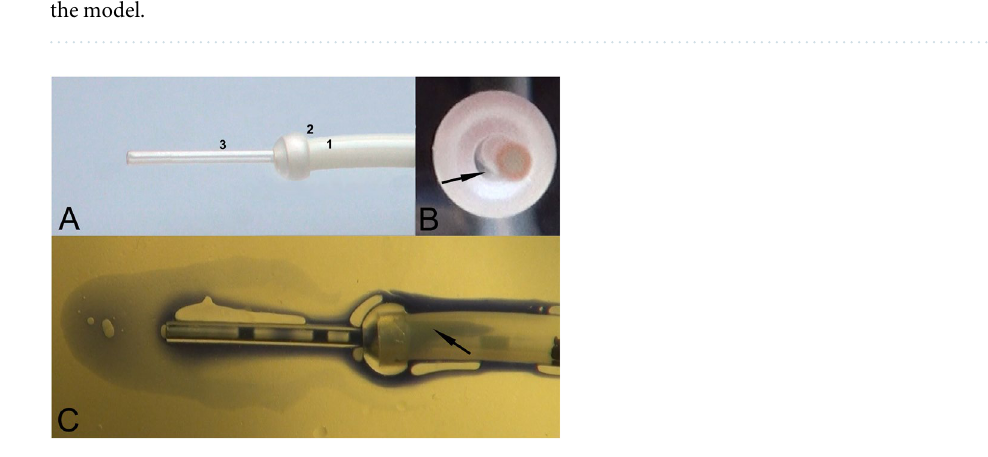
after injection. Subsequently, at 1 s, most of the fluid being transferred moved away from the catheter; a small portion moved along the inner catheter toward the outer sheath but did not reach it (Fig. 1B). Interestingly, the air